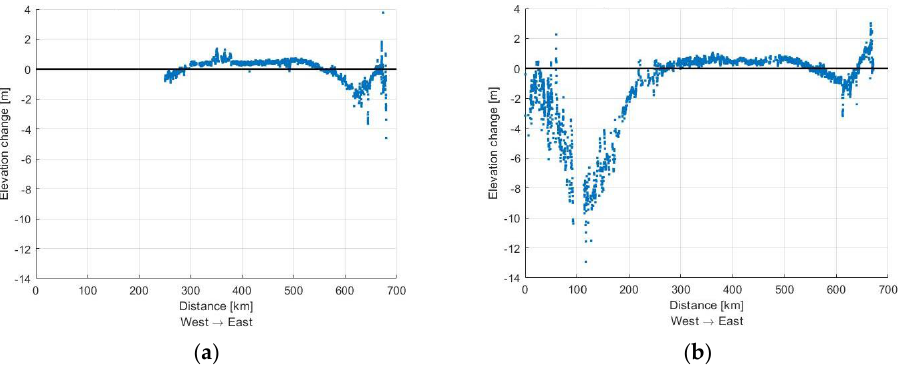
Figure 11. Comparison of crossing points ( a ) 2015 – 2020 and ( b ) 2015 – 2021.